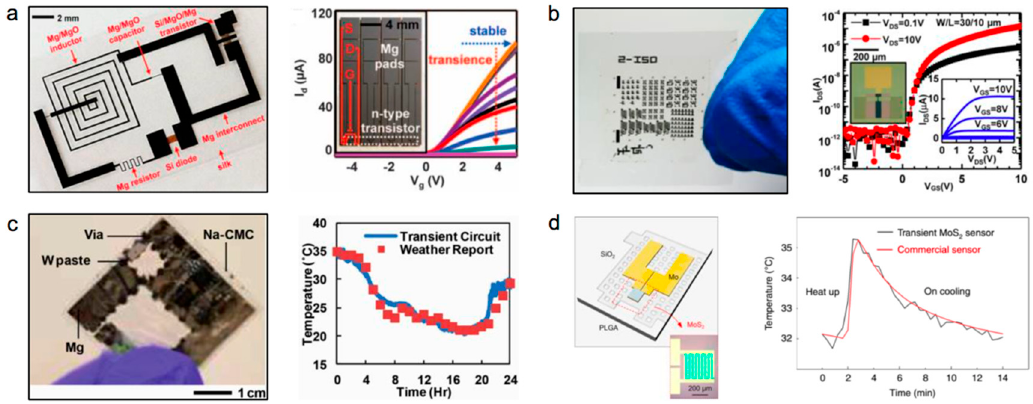
Figure 1. Different functional materials for soft and biodegradable devices. ( a ) Left: The circuit includes Si/MgO/Mg transistors, Si diodes, Mg/MgO inductors, and capacitors, as well as Mg resistors and interconnectors. Right: The transience of the operational characteristics of n-channel transistors. ( b ) Left: Schematic illustrations of transient Ga 2 O 3 /In 2 O 3 /ZnO thin film transistors (TFTs) and circuits. Right: Transfer characteristics for Ga 2 O 3 /In 2 O 3 /ZnO TFTs with widths (W)/lengths (L) (=30/10 µ m). ( c ) Left: A transient printed circuit board (PCB) device with W and Mg for the temperature sensor; Right: Comparison for environmental temperatures measured by a transient circuit and the meteorological system. ( d ) Left: A multifunctional sensor using Mo and MoS 2 ; Right: Measurement of the intracranial temperature with transient MoS 2 and commercial sensors. Reproduced with permission from [14,27,28,45].